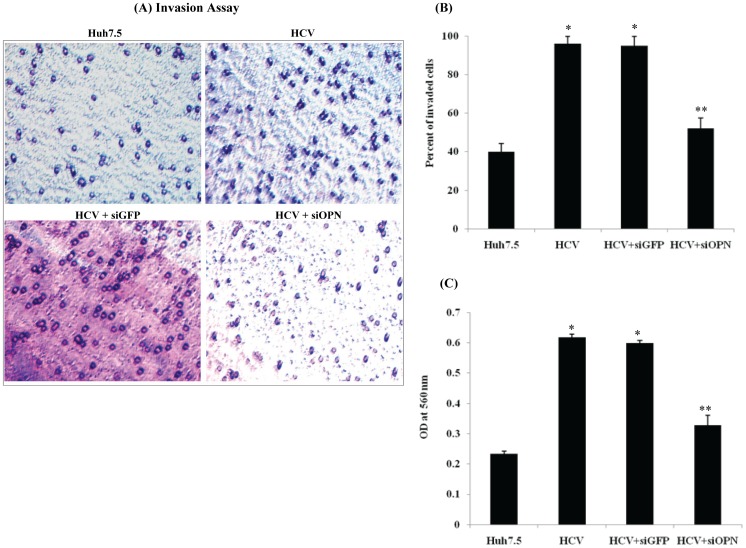

HCV promotes invasion of hepatoma cells.
(A) HCV-infected cells (from the same pool of figure 2A) were transfected with
                            siGFP and siOPN. At 24 h posttransfection, approximately
                                3×105 cells were seeded in transwell chamber for
                            48 h and images of invaded cells were recorded under microscope at least
                            three individual fields per well at 10× magnification. (B) The
                            invaded cells were counted in at least three individual fields per
                            insert and represented by bar diagrams. The results shown are
                            representative of two independent experiments performed in duplicate.
                            (C) The above invaded cells were quantified in 96 wells plate at OD 560
                            nm using extraction buffer. Data represent means ± SD of two
                            independent experiments performed in duplicate. *denotes p<0.05
                            compared to mock-infected Huh7.5 cells. **denotes p<0.05
                            compared to HCV-infected cells transfected with siGFP.